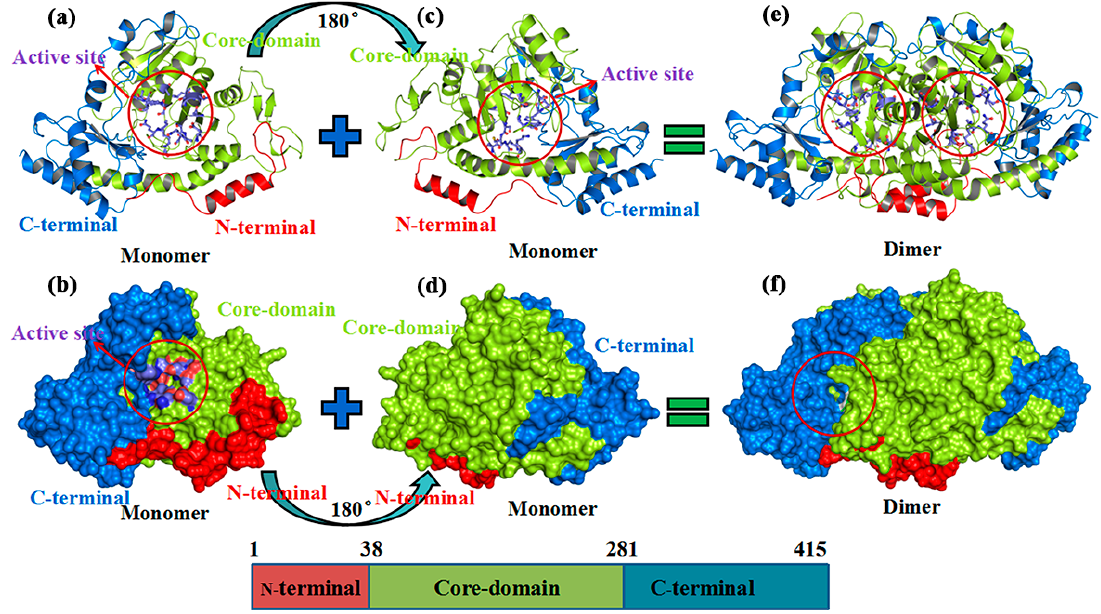
Figure 1. Overview of aminotransferase (PDB (protein data bank):5W71). ( a , b ) 3D structure of aminotransferase. The N terminal (residues 1 to 37), which contained one α -helix, is colored in red. The core domain (residues 38 to 281) is colored in deep teal. The C terminal (residues 282 to 415) is colored in forest. The active site is colored in lavender. ( c , d ) The aminotransferase are rotated 180. ( e , f ) Homologous dimer with the active site located between two monomers.